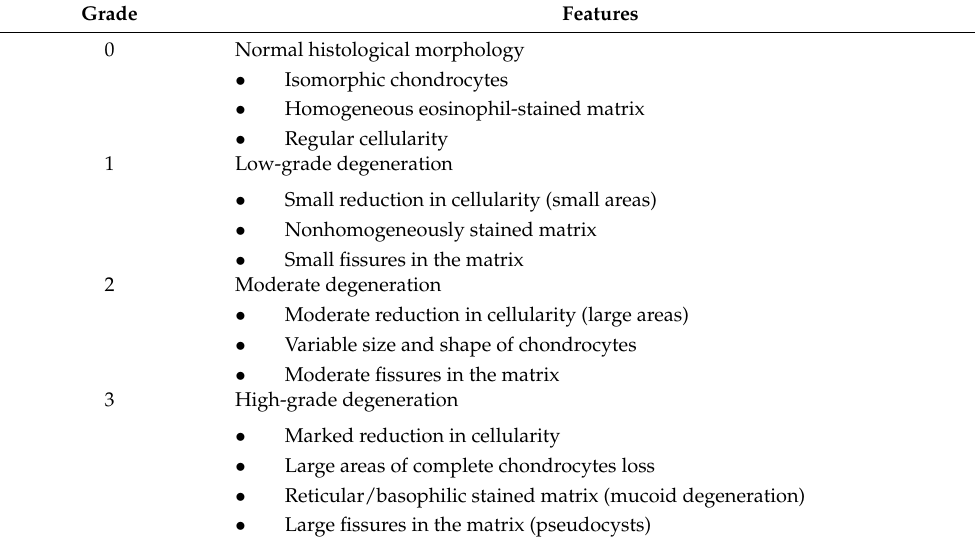
Table 2. Krenn score: histopathological evaluation of the grade of fibrocartilage degeneration